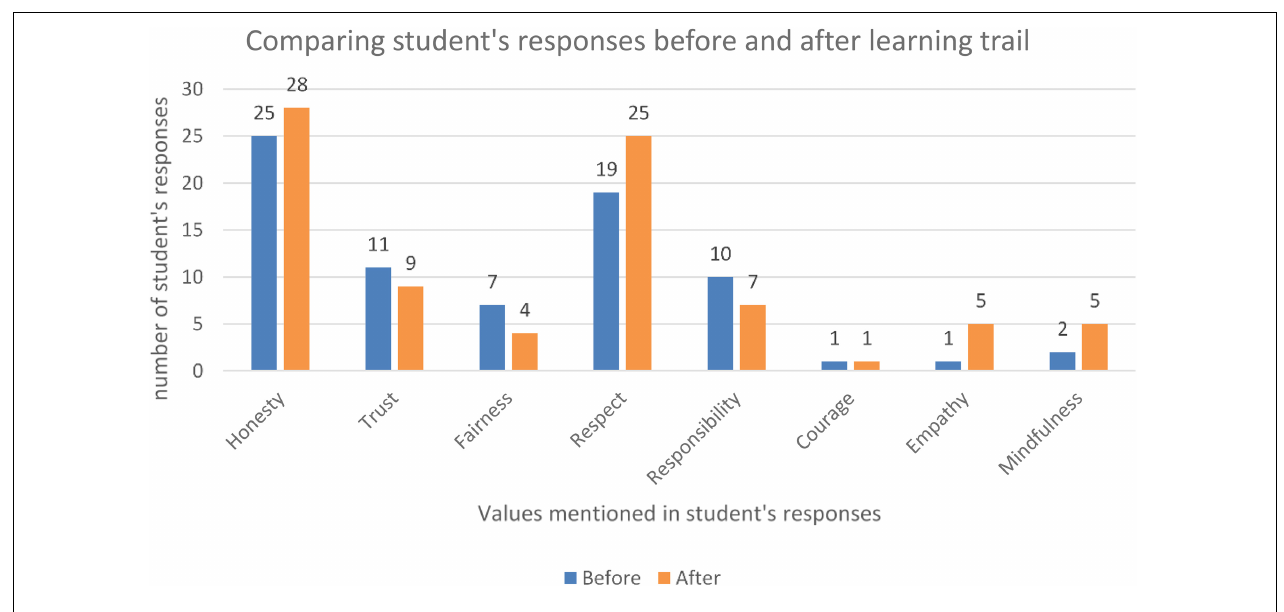
FIGURE 2 | Comparing student’s responses before and after learning